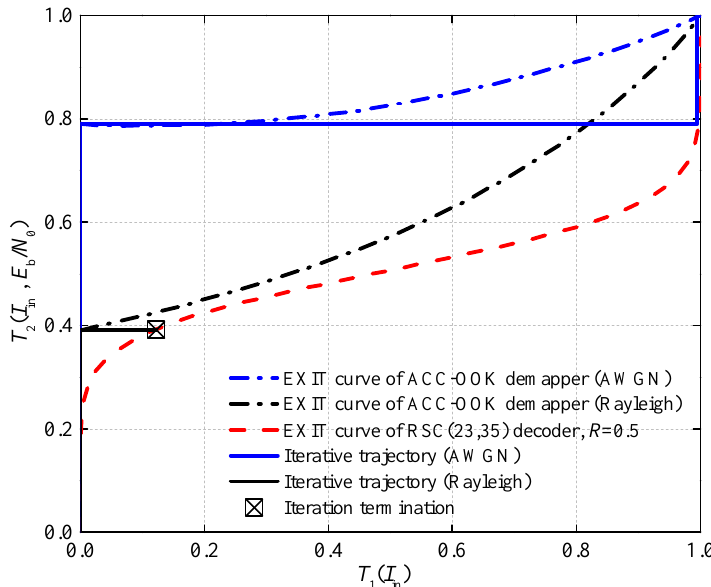
Figure 3. Premature terminated iteration of the system using RSC under the Rayleigh fading channel, E b / N 0 = 11.3